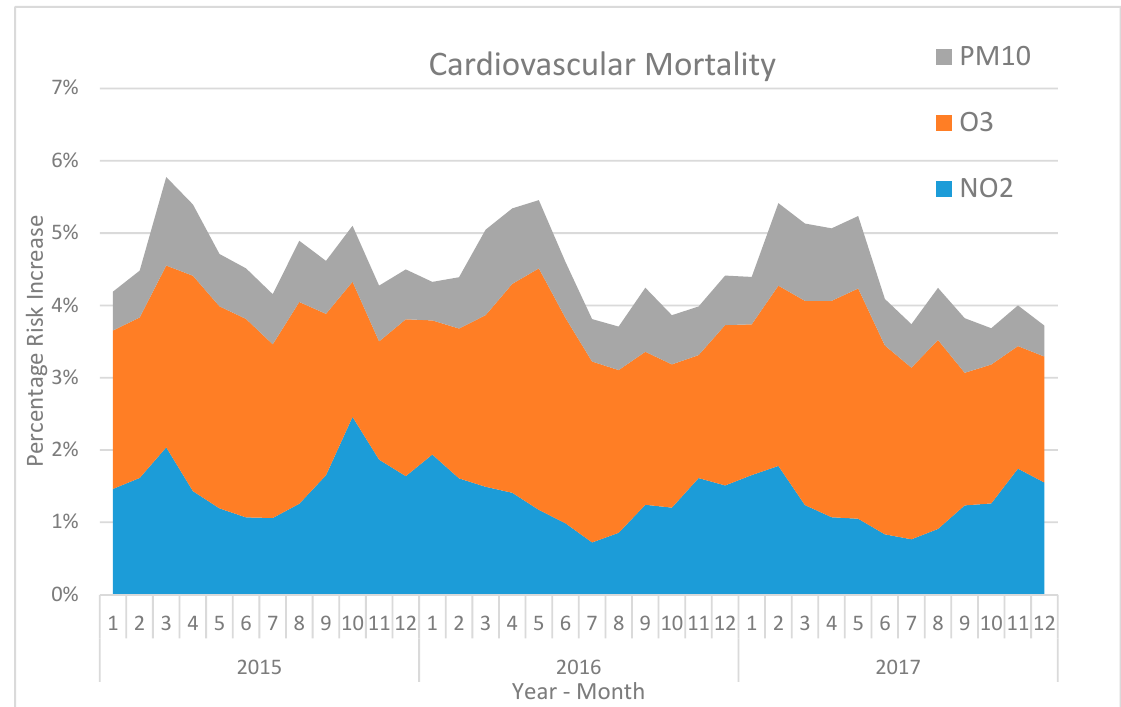
Figure 2. The calculated average monthly percentage risk increase associated with NO 2 , O 3 , and PM 10 for all-cause mortality in elderly in Stockholm during 2015–2017 based on meta-coefficients [8].